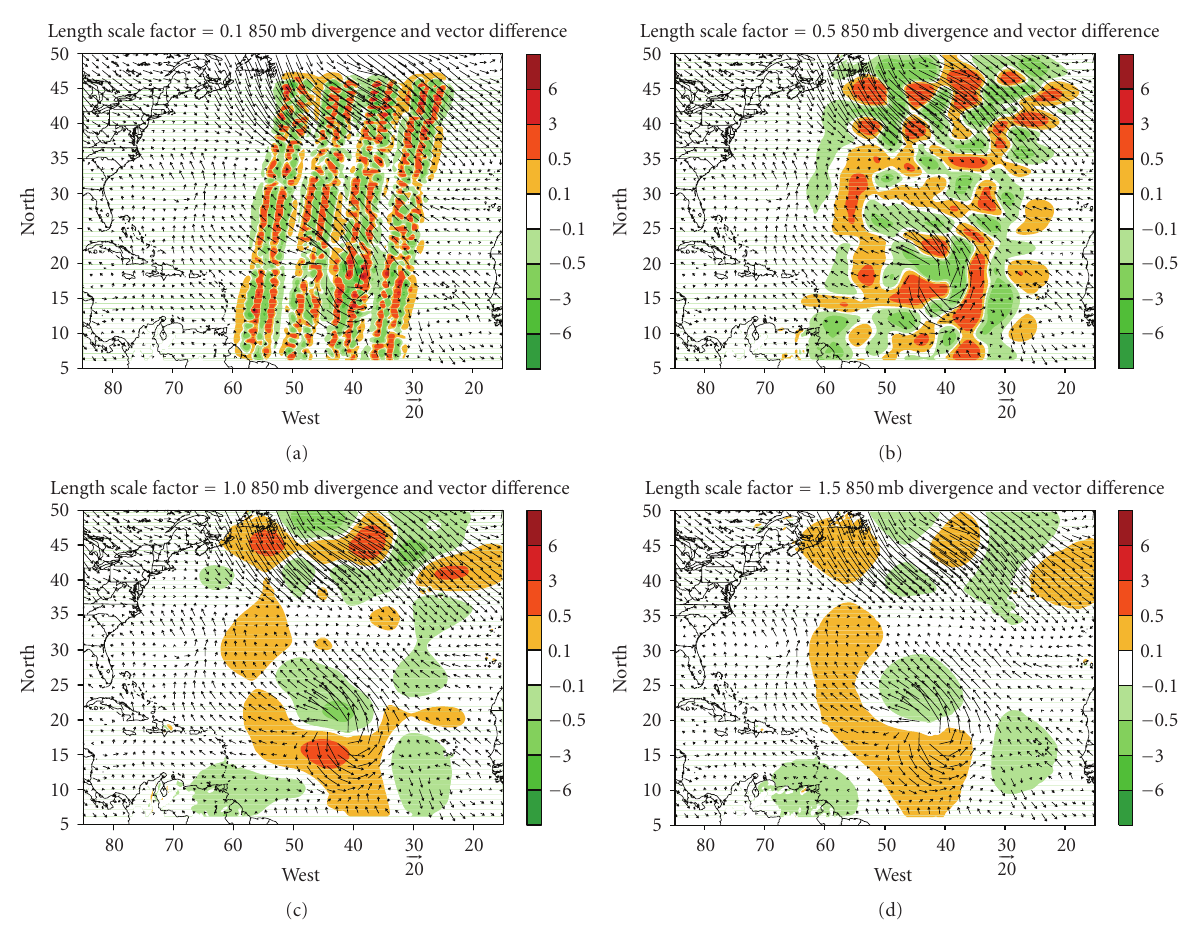
Figure 2: Horizontal wind and divergence increments at 850 hPa for length scale factor of 0.1 (a), 0.5 (b), 1.0 (c), and 1.5 (d) at 0600 UTC 01 October 2005. Table 1: Summary of model set up for all